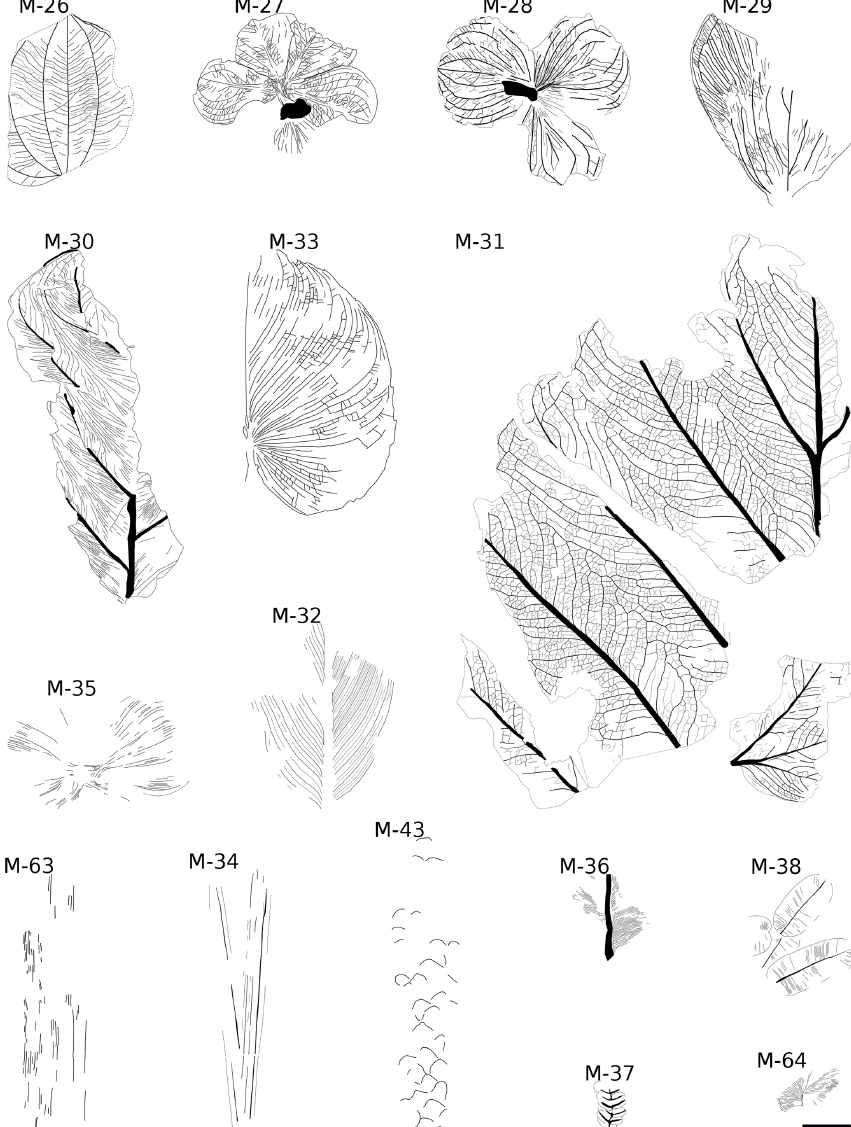
Figure 4. Line drawings of monocot, conifer (only M-43), and fern (M-36, M-37, M-38, M-64) morphotypes, Baris, Egypt. The scale bar is